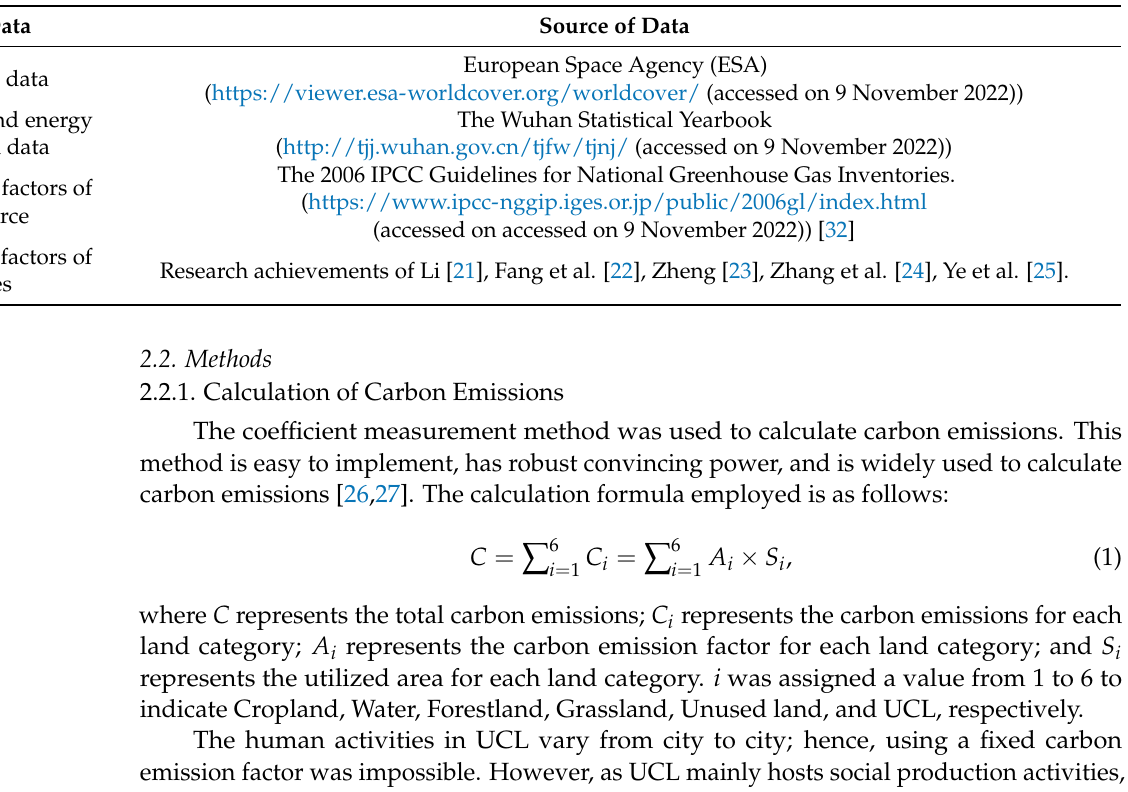
Table 1. Data Source.